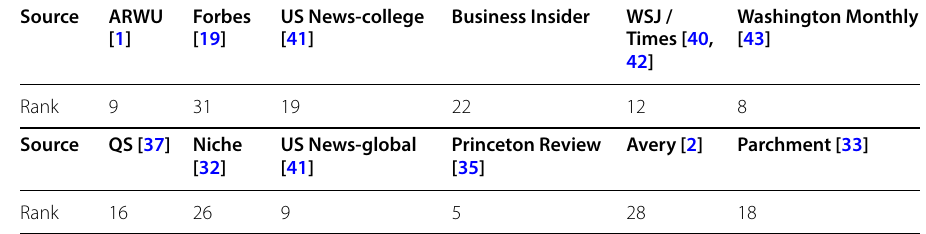
ARWU [1] and QS [37] for Academic Ranking of World Universities and Quacquarelli Symonds [37], respectively From websites cited in the reference, accessed 18 March 2019 Liberal arts colleges and military academies are